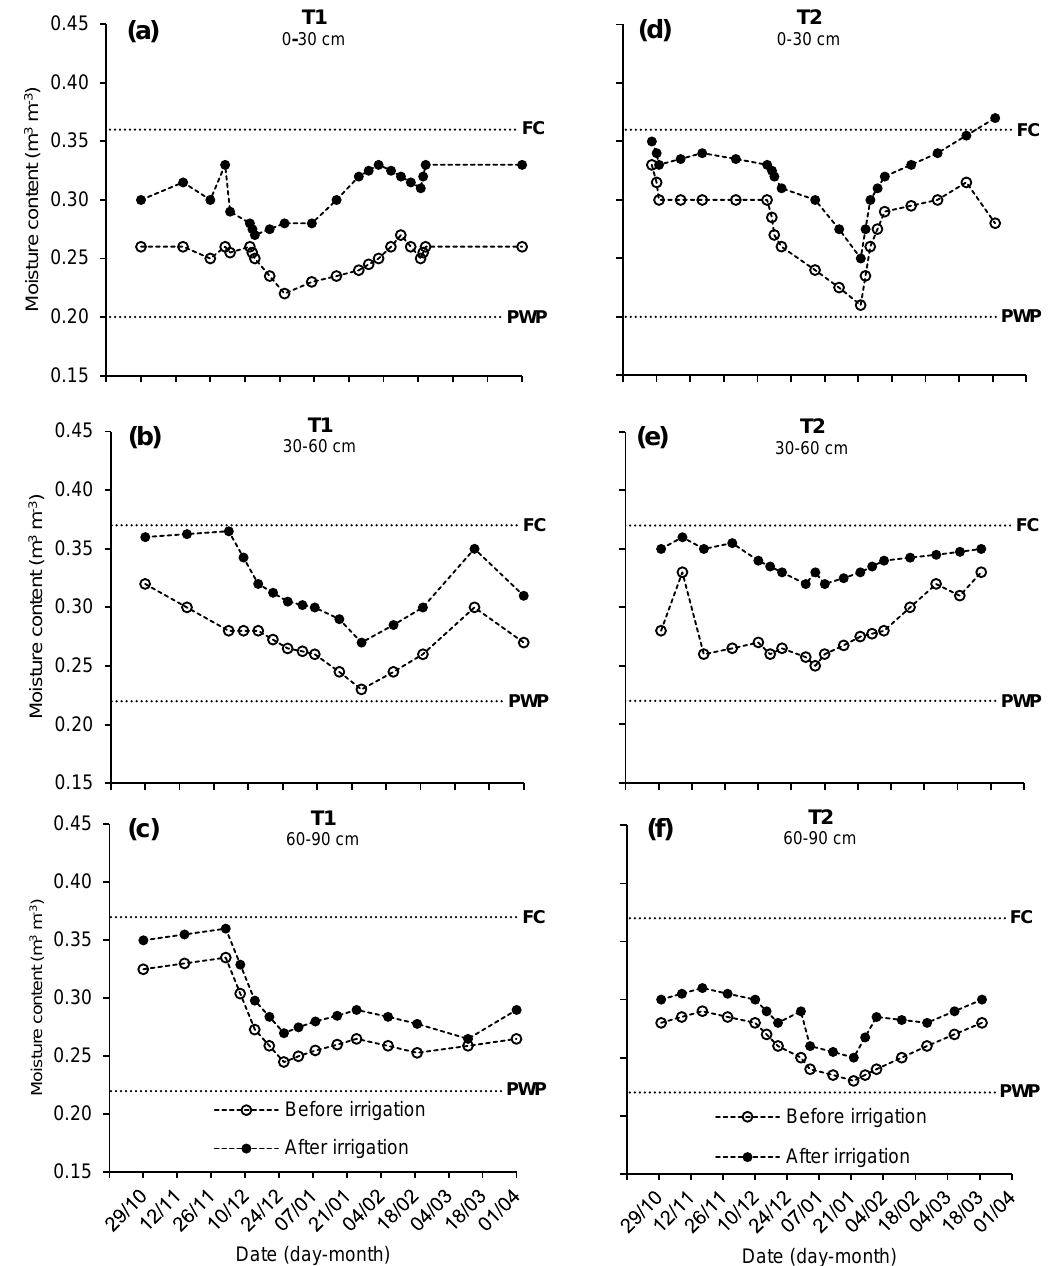
Figure 5. Cycles of soil moisture content before and one day after irrigation in the ( a , d ) 0–30 cm, ( b , e ) 30–60 cm, and ( c , f ) 60–90 cm strata throughout the 2008–2009 irrigation season for two microjet irrigation treatments of ‘Royal Gala’ apple trees. T1: Irrigation with theoretical volume required by the plant. T2: Irrigation with farm protocol. Each point is the average of 12 readings. FC is field capacity and PWP is permanent wilting point.